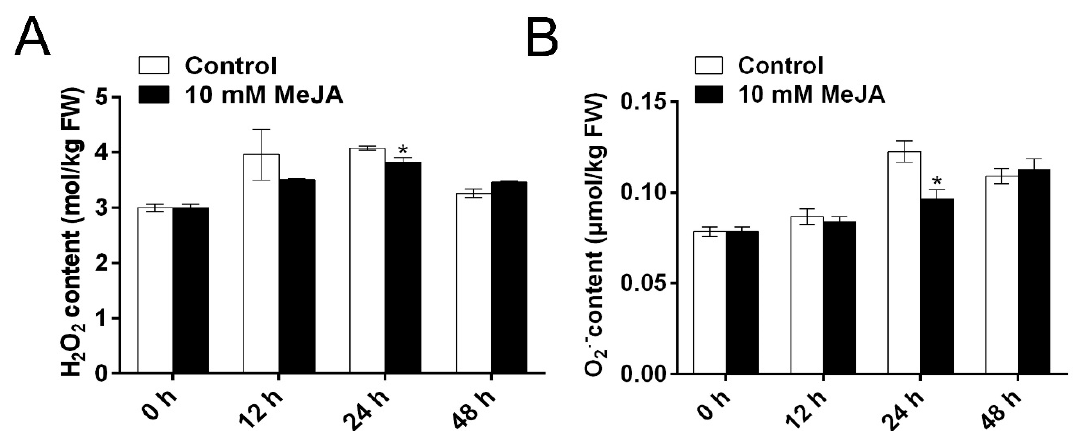
Figure 2. MeJA alleviates cell oxidative damage through modulation of reactive oxygen species (ROS) in cassava tuberous roots during PPD. The concentrations of H 2 O 2 content ( A ) and O 2 − content ( B ) of cassava tuberous roots. Data are means ± SD calculated from three biological replicate samples. Asterisk symbols (*) indicate significant differences according to Duncan’s multiple range test at p < 0.05 at the same time points.